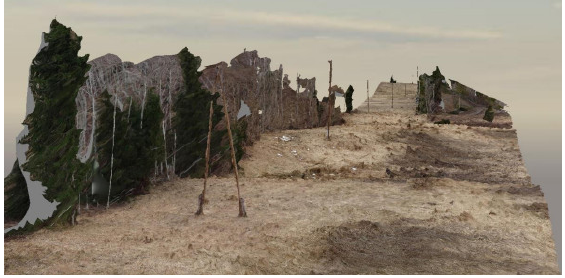
Figure 14. Example of data processing with photogrammetry method.